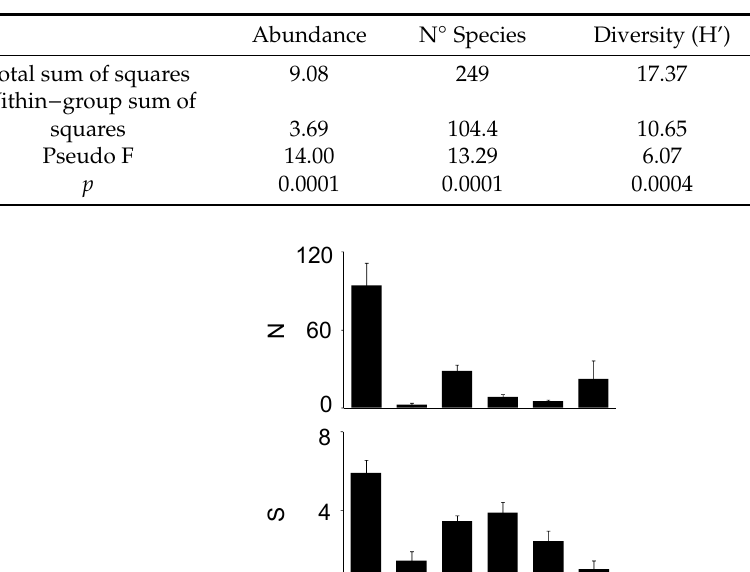
Table 6. Results of PERMANOVA (based on Euclidean distance) testing di ff erences among sites for abundance, number of species, Shannon diversity (H’), and biomass. Permutation number = 9999. All values are significant at p < 0.0005.